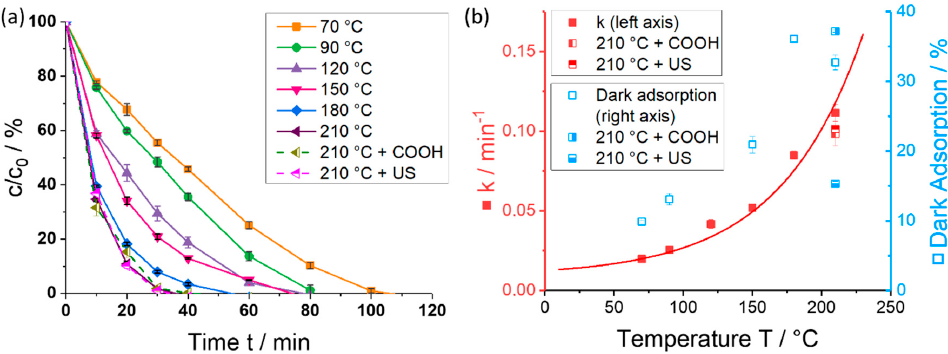
Figure 7. ( a ) Photocatalytic degradation of methylene blue (13 mg L − 1 ) over time and ( b ) reaction rate constant of the photocatalytic degradation and dark adsorption for differently synthesized membranes (unmodified PES membrane, PES membrane with TiO 2 nanoparticles synthesized at